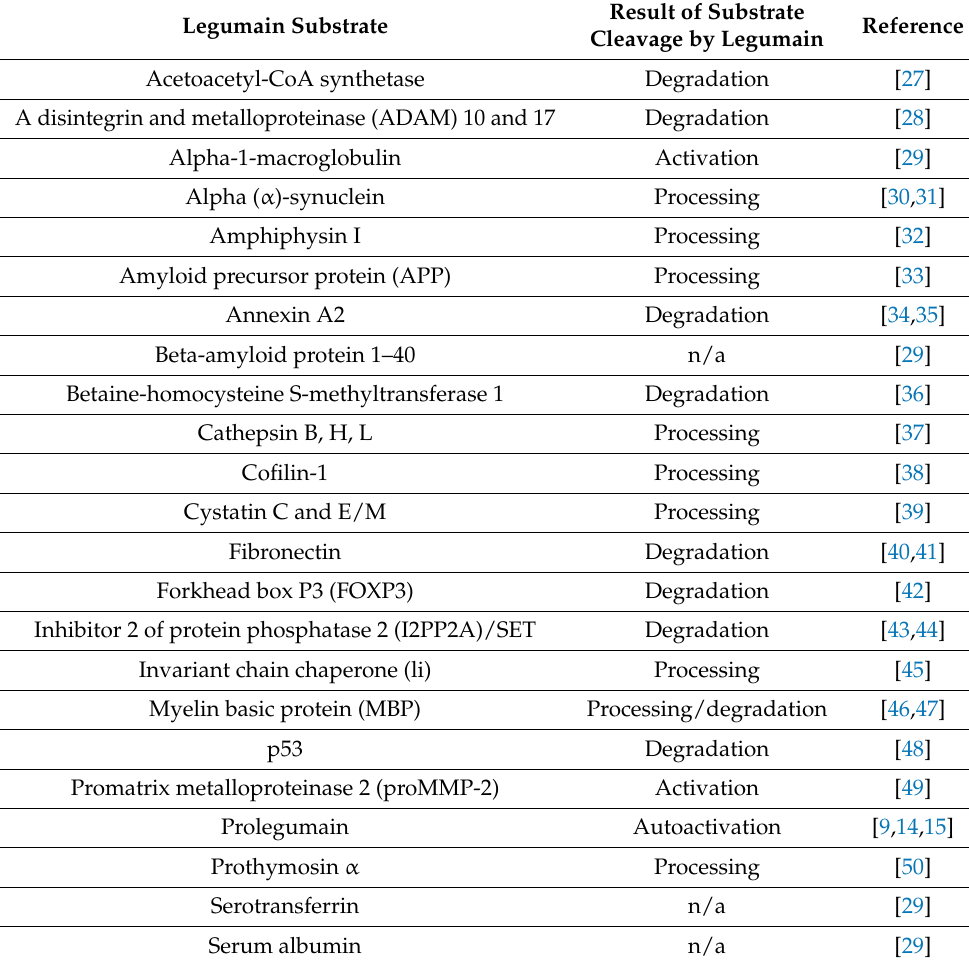
Table 1. Known mammalian AEP substrates of legumain (alphabetical